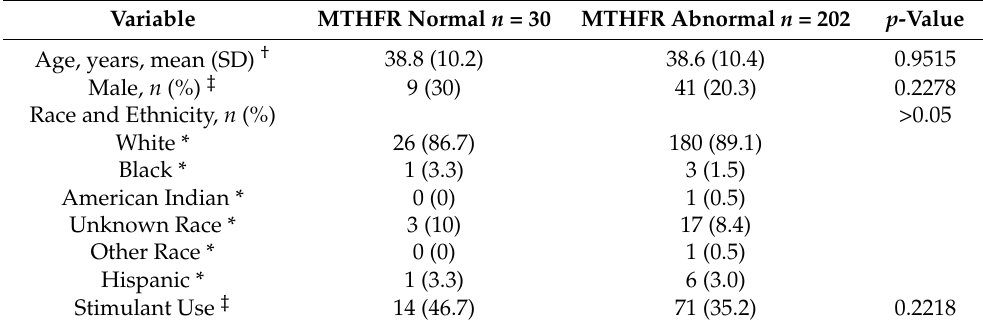
Table 1. Overall comparison of normal MTHFR allele and any variant MTHFR allele.